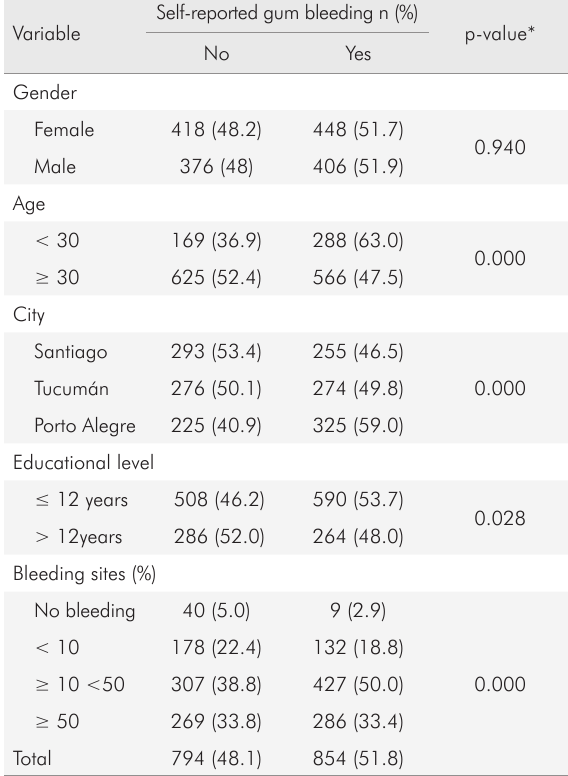
Table 6. Self-reported gum bleeding according to gender, age, city, educational level and % bleeding sites per